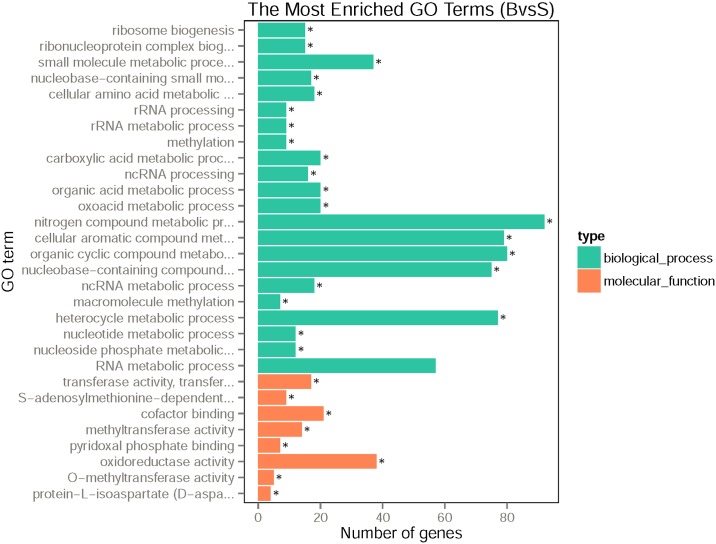
Gene ontology (GO) term enrichment of up-regulated genes in B group.x-axis represent the number of up-regulated genes in B group, y-axis represent the GO terms; Green bars represent biological process, Orange bars represent molecular function; “*” represent the significantly enriched terms (corrected P-value less than 0.05).